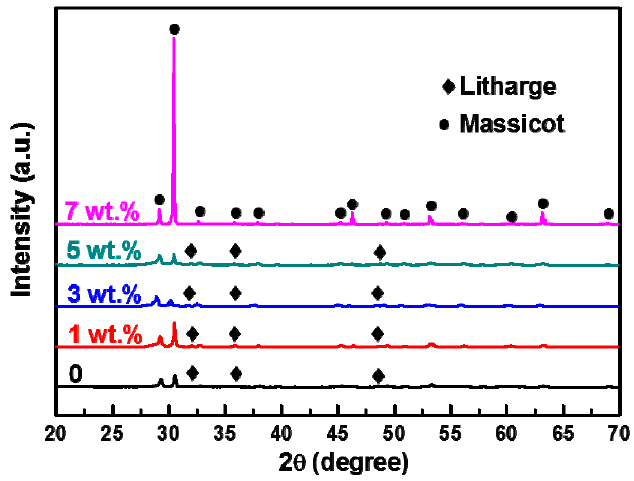
Figure 6. XRD patterns of PbO ceramic pellets sintered at 620°C with different wt.% of Bi 2 O 3 .